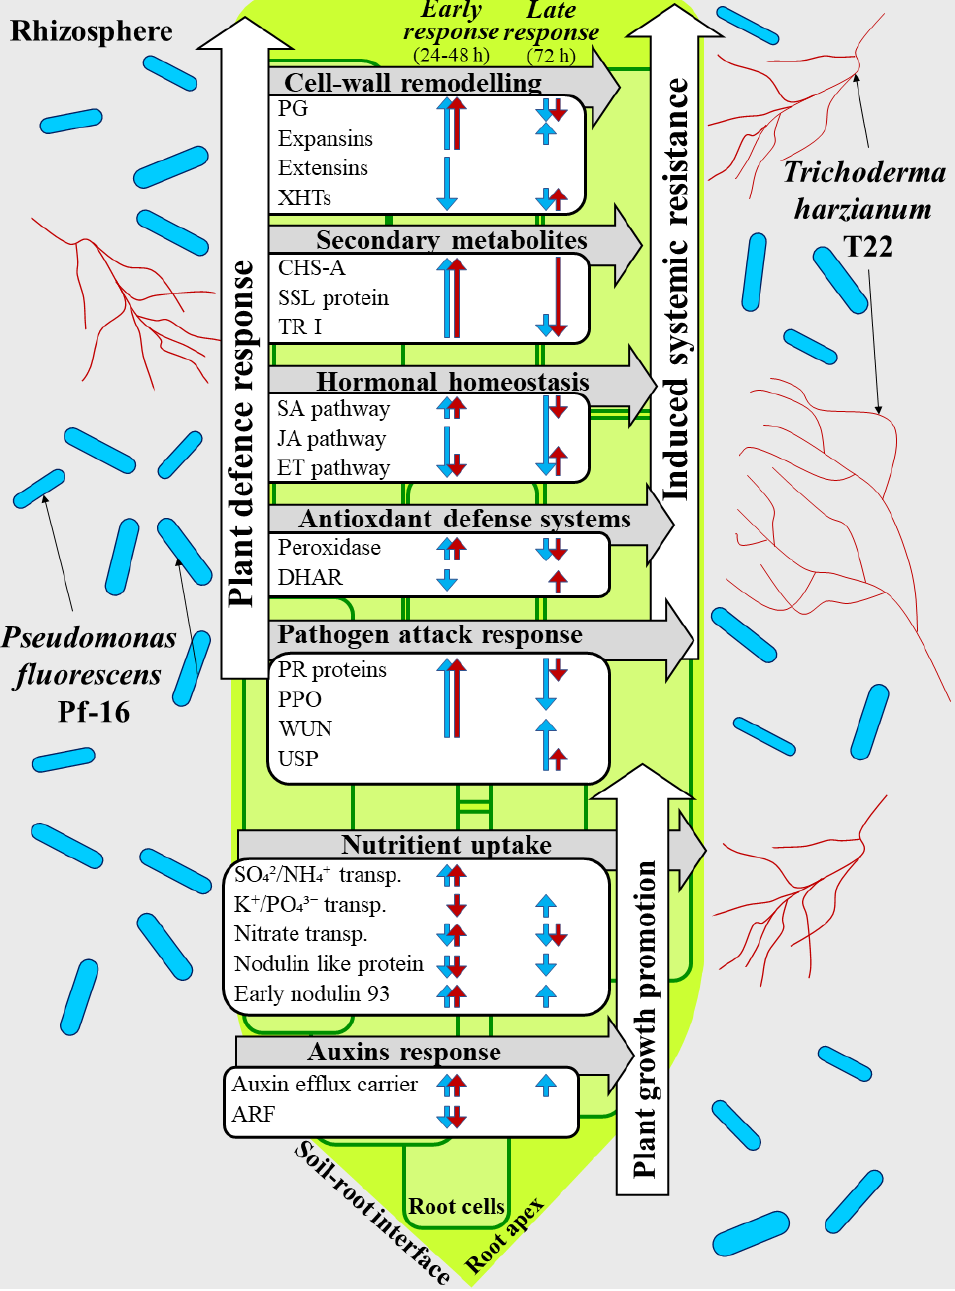
Figure 2. Model of the early molecular events occurring in the tomato root–PGPM interaction. Overview of tomato root transcriptomic responses after inoculum with Trichoderma harzianum T22 and Psuedomonas fluorescens Pf-16. The highlighted functions derive from the annotation of differentially expressed genes as reported in De Palma et al. [17] and Scotti et al. [18]. Tomato genes that were significantly up-regulated and down-regulated in response to T. harzianum T22 or P. fluorescens Pf-16 at each time point (24, 48, and 72 h post-inoculum) are in red and blue, respectively. PG: polygalacturonases; CHS-A: Chalcone synthase-A; SSL: Strictosidine synthase-like; TR: tropinone reduc-